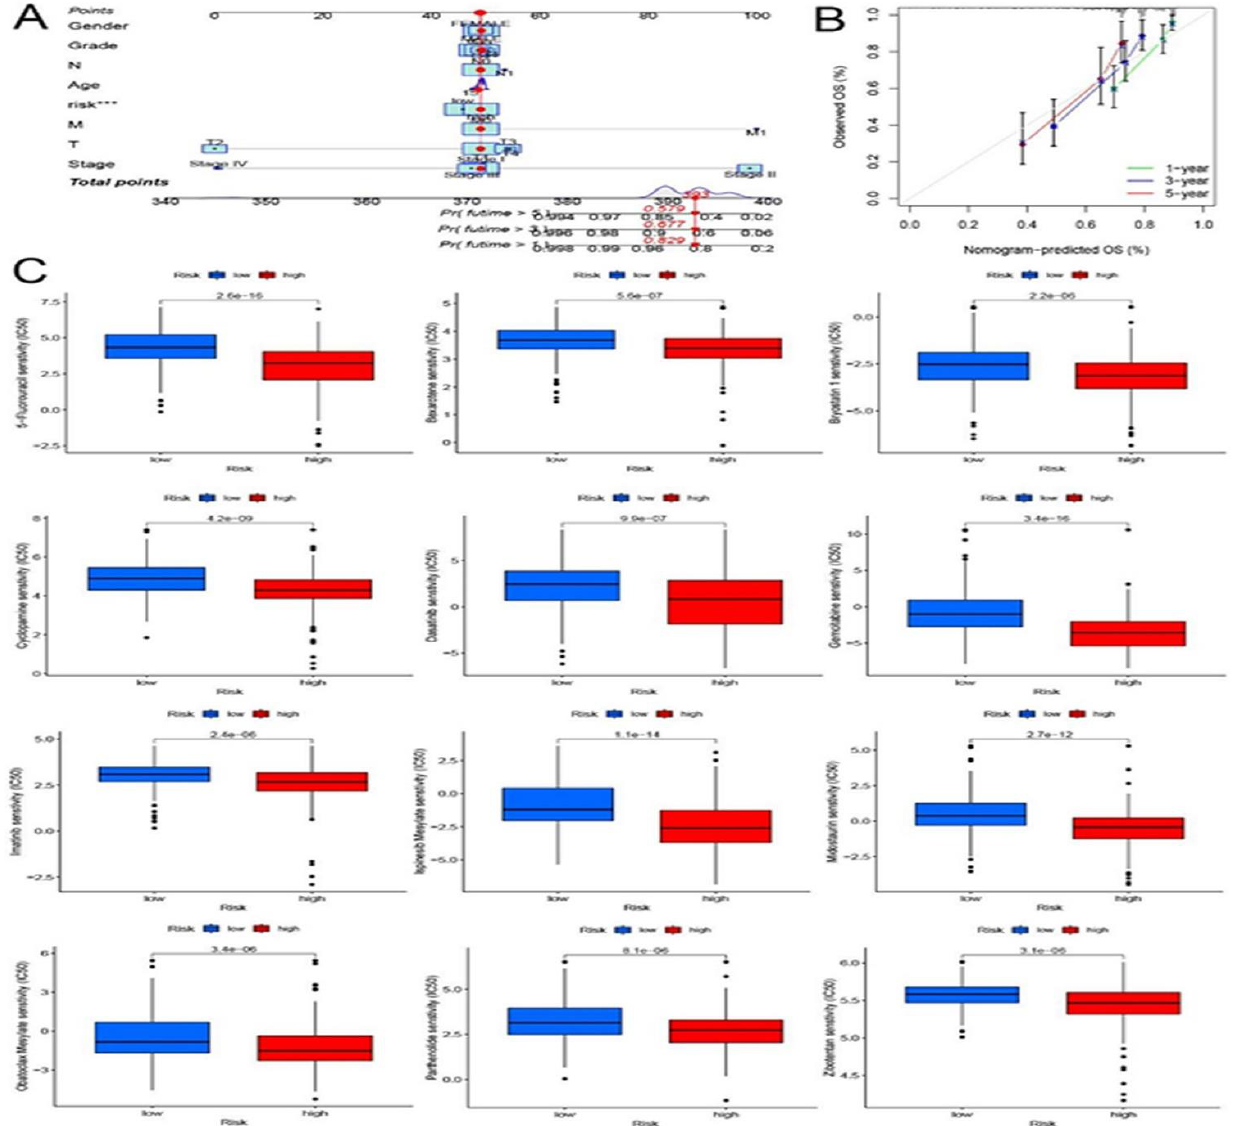
Figure 5: Construction of nomogram, (A) nomogram used to predict 1-, 3-, and 5-year survival in patients with liver cancer. (B) Calibration curve of nomogram used to predict model survival probability. (C) Drugs with significant differences in drug sensitivity in high and low risk